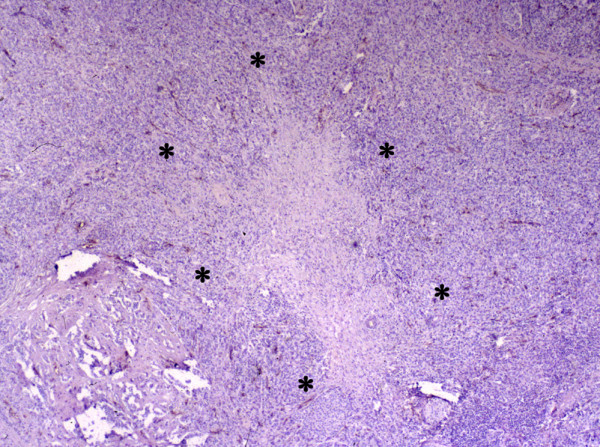
Central microvessel count – VEGF. After scanning at low power (40×), the central area of the tumor was estimated. From this area, six high power (200×) fields were evaluated for each section. The average number of microvessels per high power field was determined and reported as CMC.